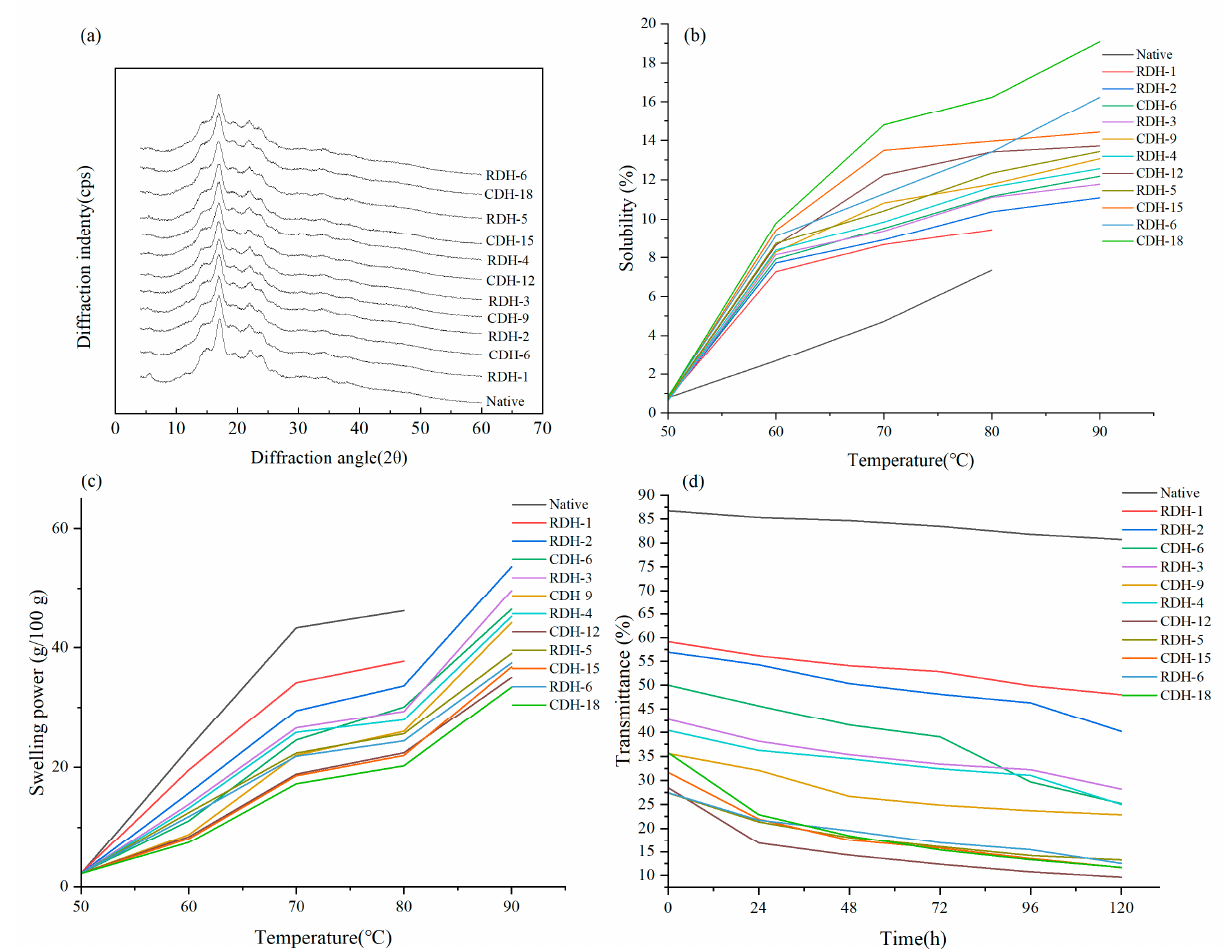
Figure 2. X-ray diffraction patterns ( a ), Solubility ( b ), swelling power ( c ) and transmittance ( d ) of the native, CDH and RDH-treated potato starch samples.